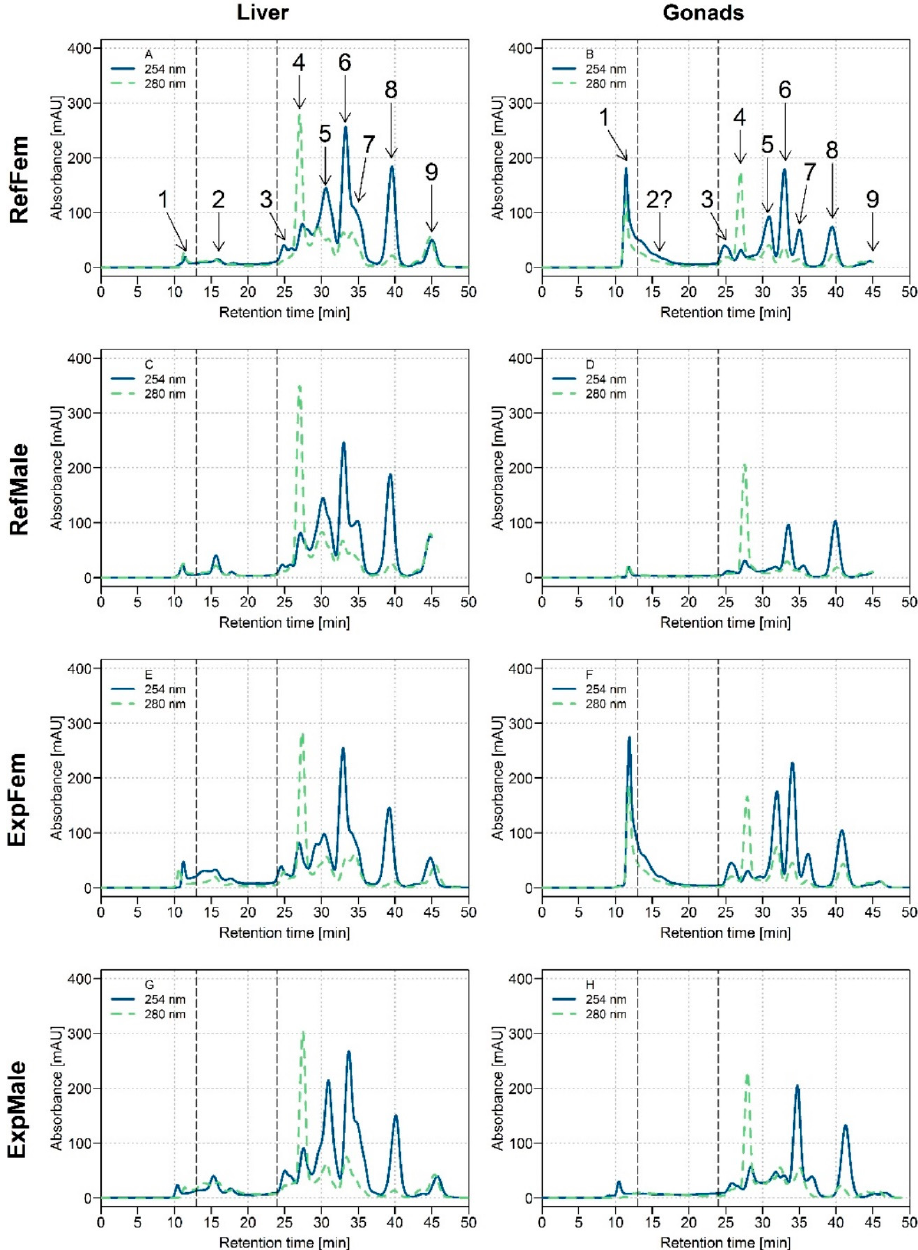
Figure 1. Size-exclusion chromatograms with ultraviolet (UV) detection at 254 nm (blue plain line) and 280 nm (olive dotted line) in the heat-treated cytosolic (HSP) fraction of white suckers for male and female livers and gonads. Vertical dotted lines delimit the three operationally defined molecular weight biomolecule pools: medium molecular weight (MMW) (0–13 min; >10 kDa), low molecular weight (LMW) (13–24 min; 10–2 kDa) and very low molecular weight (VLMW) (>24 min; <2 kDa). ( A ) Liver of reference females (RefFem); ( B ) Gonads of reference females (RefFem); ( C ) Liver of reference males (RefMale); ( D ) Gonads of reference males (RefMale); ( E ) Liver of exposed females (ExpFem); ( F ) Gonads of exposed females (ExpFem); ( G ) Liver of exposed males (ExpMale); ( H ) Gonads of exposed males